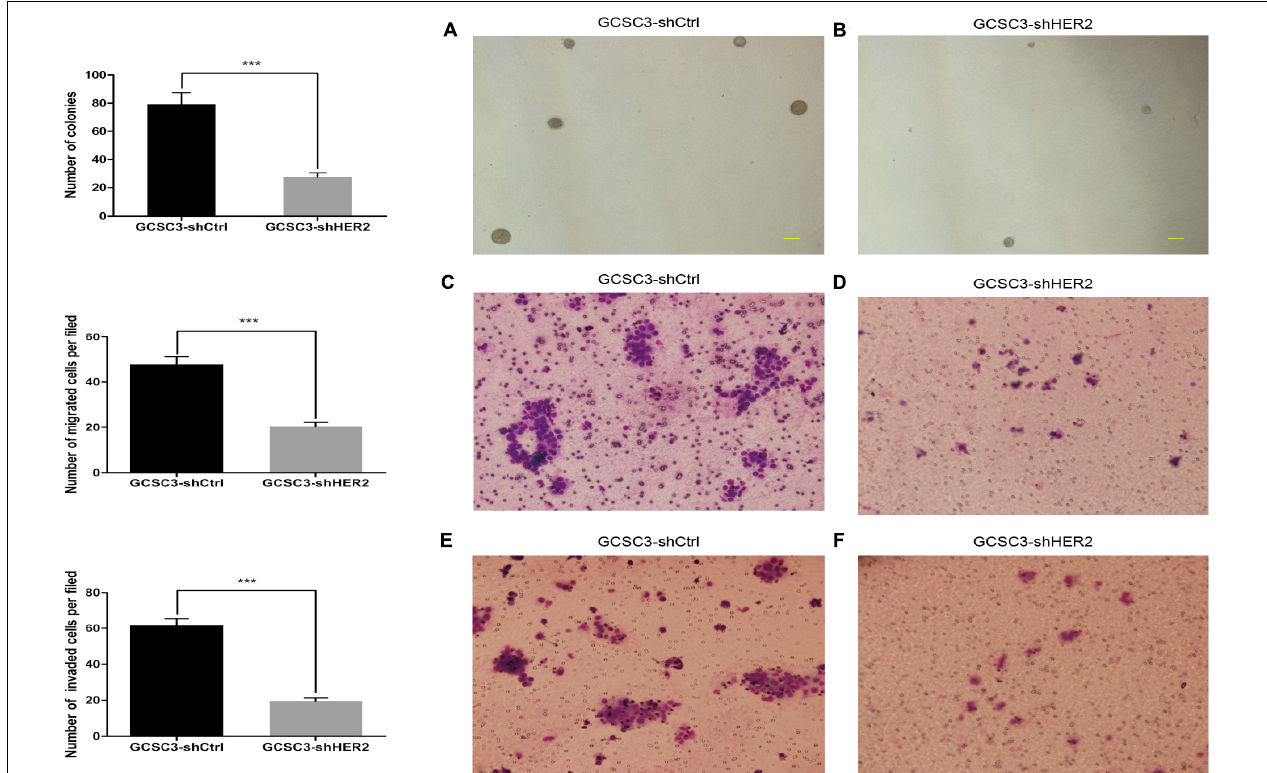
FIGURE 3 | Ability of colony formation, invasion, and migration in GCSCs was detected after down-regulation of HER2. Pictures (A,B) show the colonies of GCSC3-shCtrl and GCSC3-shHER2, respectively. Representative pictures were taken at × 40 magnification, and scale bars represent 200 µ m. The result showed GCSC3-shCtrl had a higher colony formation rate than GCSC3-shHER2 (79.33 ± 4.63 vs. 27.33 ± 1.76, p < 0.001); data were expressed as mean ± SEM, *** p < 0.001. Pictures (C,D) show that GCSC3-shCtrl had a higher capacity of migration than GCSC3-shHER2 (47.93 ± 3.38 vs. 20.27 ± 2.13, p < 0.001); and pictures (E,F) show that GCSC3-shCtrl had a higher capacity of invasion than GCSC3-shHER2 (61.87 ± 3.71 vs. 19.67 ± 1.71, p < 0.001). Representative pictures were taken at × 200 magnification. Data were expressed as mean ± SEM, *** p < 0.001.